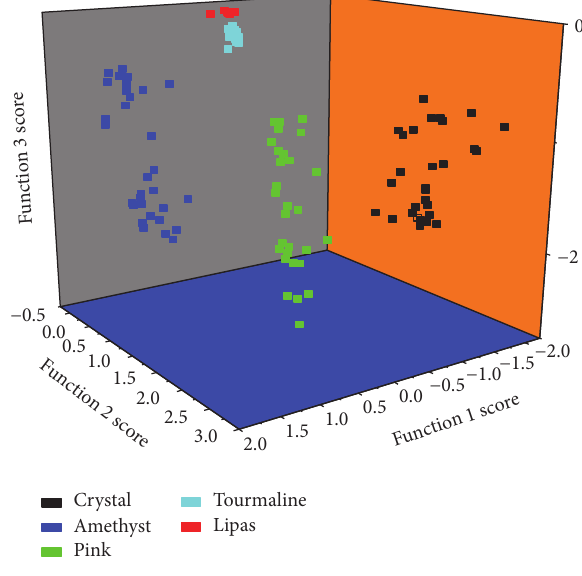
Figure 6: 3D plot of all five types of